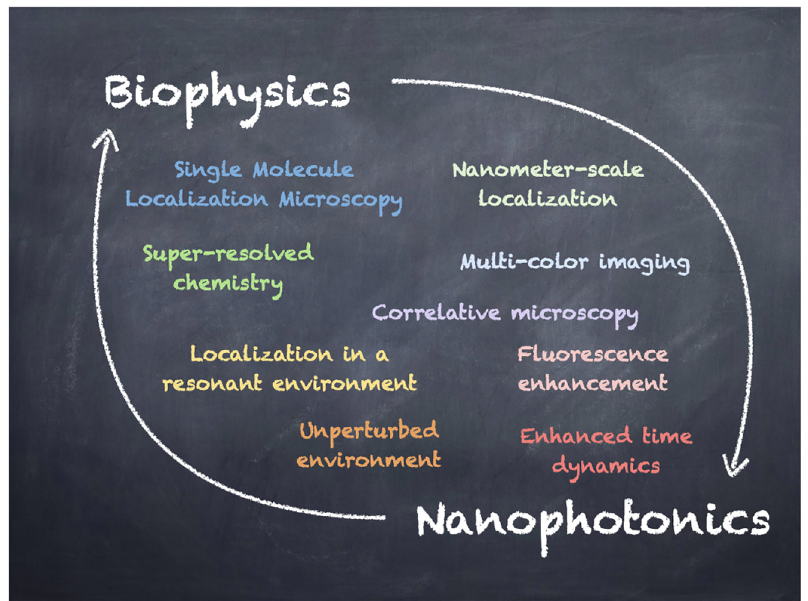
Figure 1: Graphical table-of-content of the review. Interaction between biophysics